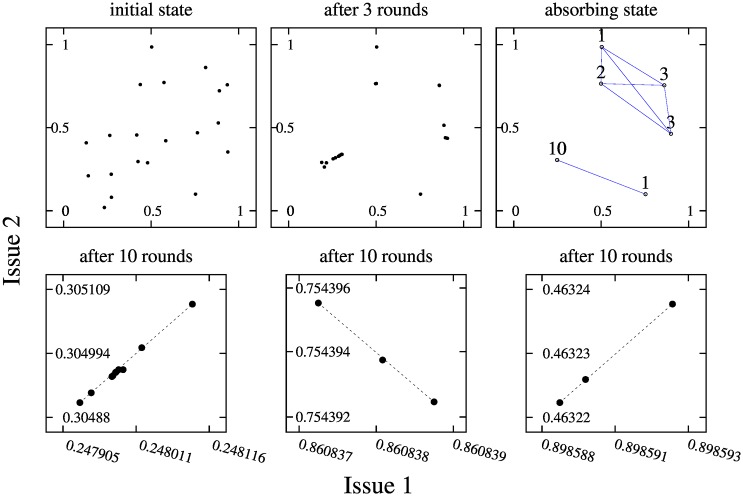
The upper panels present three snapshots of the evolution of opinions in a system for 20 agents, ε = 0.2, p = 0.3, and with a distribution of initial opinions that is shown in the upper left panel.The final absorbing state (shown in the upper right panel) corresponds also to the the upper right panel in Fig 7 (case ε = 0.2). The three bottom panels show a zoom of the distribution of opinions of the members of an opinion group just before reaching the final absorbing state. The bottom left, center and right panels correspond to the groups with 10, 3, and 3 agents, respectively.